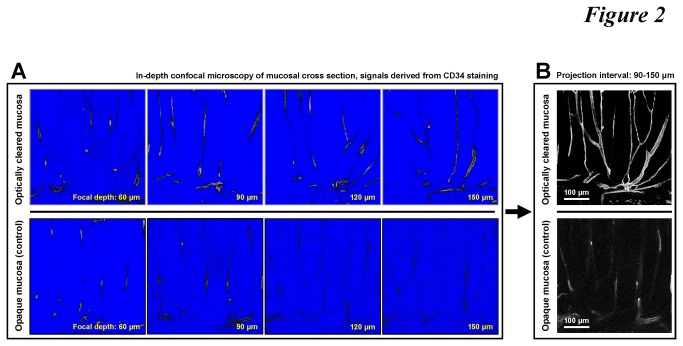
Deep-tissue microscopy of microvessels in normal colon mucosa.(A) Extended imaging depth in confocal microscopy with optical clearing. Upper panels show the CD34 signals of mucosal microvessels in the optically cleared mucosa, while in the opaque mucosa (lower panels, saline immersion) the signals drastically declined as the focal plane progressed into the tissue. Signal intensities are presented in grayscale, red (signal saturation), and blue (no signals). Video S1 compares the image stacks derived from the two optical conditions as the focal depth progressed from 0 to 150 μm. (B) Projection of the vascular signals derived from the optically cleared and opaque colon mucosa.